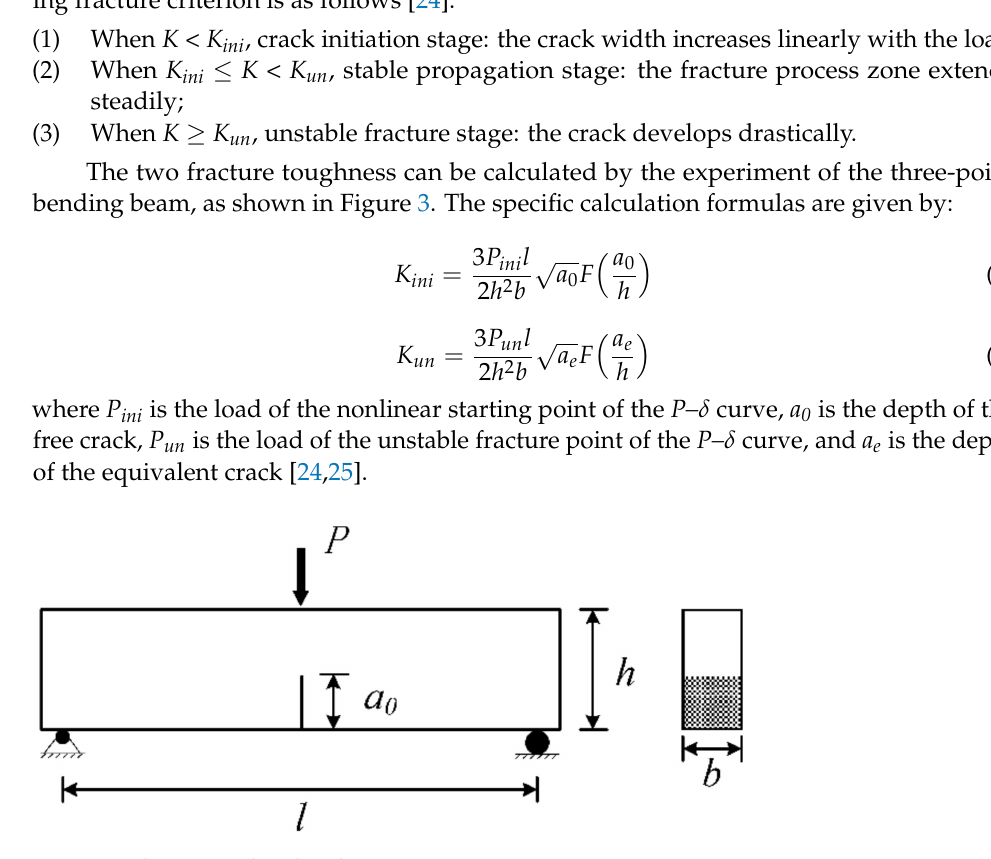
Figure 3. Three-point bending beam